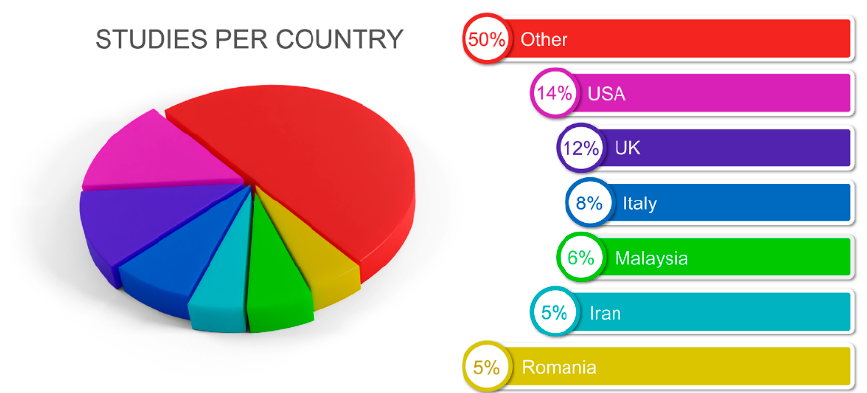
Figure 3. Percentage of studies per country.